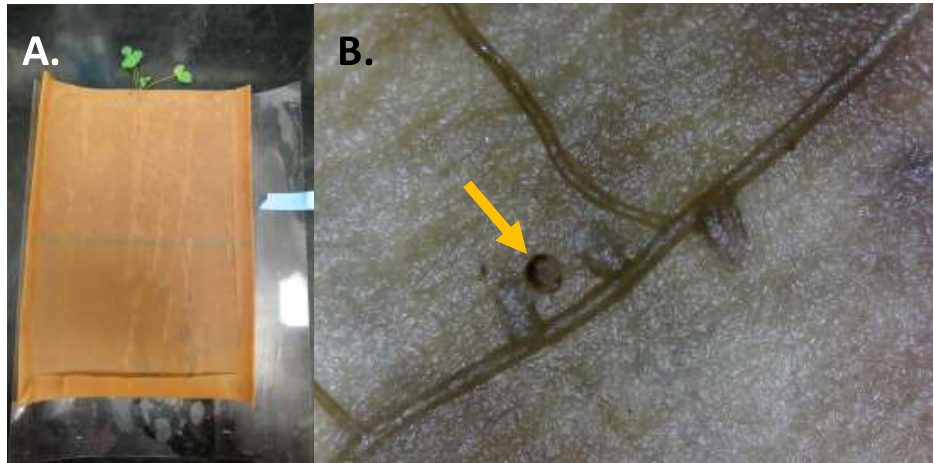
Figure 2. To evaluate alfalfa root nodule feeding and CRC larval survivorship and development, the arena ( A ) consisting of an outer transparency film cover and developing plant within germination paper was unfurled. The germination paper provided a substrate for roots and nodules to develop ( B ) and where a CRC larva (yellow arrow) could move and feed throughout the root zone, particularly on